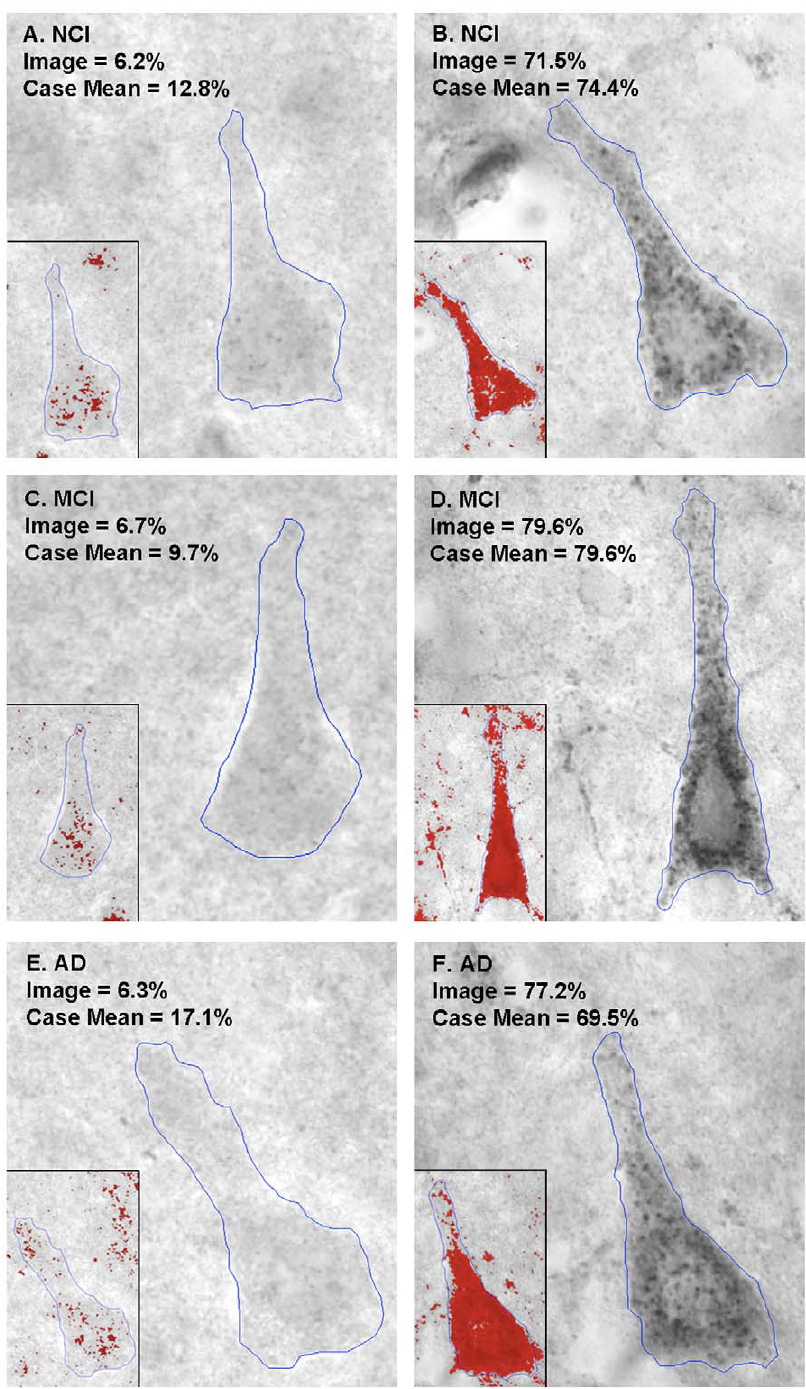
Figure 1. Representative images of LR11 immunostaining in each diagnostic group. LR11 expression in the frontal cortex was highly variable in all three diagnostic groups, as shown in these representative images demonstrating the range of staining in each diagnostic group. In all of the panels, the red overlay shown in the inset represents the pixels determined to be stained for LR11 for each pictured cell. doi:10.1371/journal.pone.0040527.g001 quantitative five point scale, with a score of 1 denoting no correlation (Spearman r= 0.71–0.82, p , 0.0001), similar to that discernable cellular LR11 staining above background and a score seen in our previous study [10]. The average semi-quantitative of 5 denoting strong, consistent cellular LR11 labeling across the score of the three raters also showed good correlation with the quantitative LR11 measures (Spearman r=0.73, p , 0.0001), brain section. The three raters showed moderate agreement (average weighted kappa, k = 0.56, range 0.37–0.69) and good confirming that our quantitative IHC approach produced a